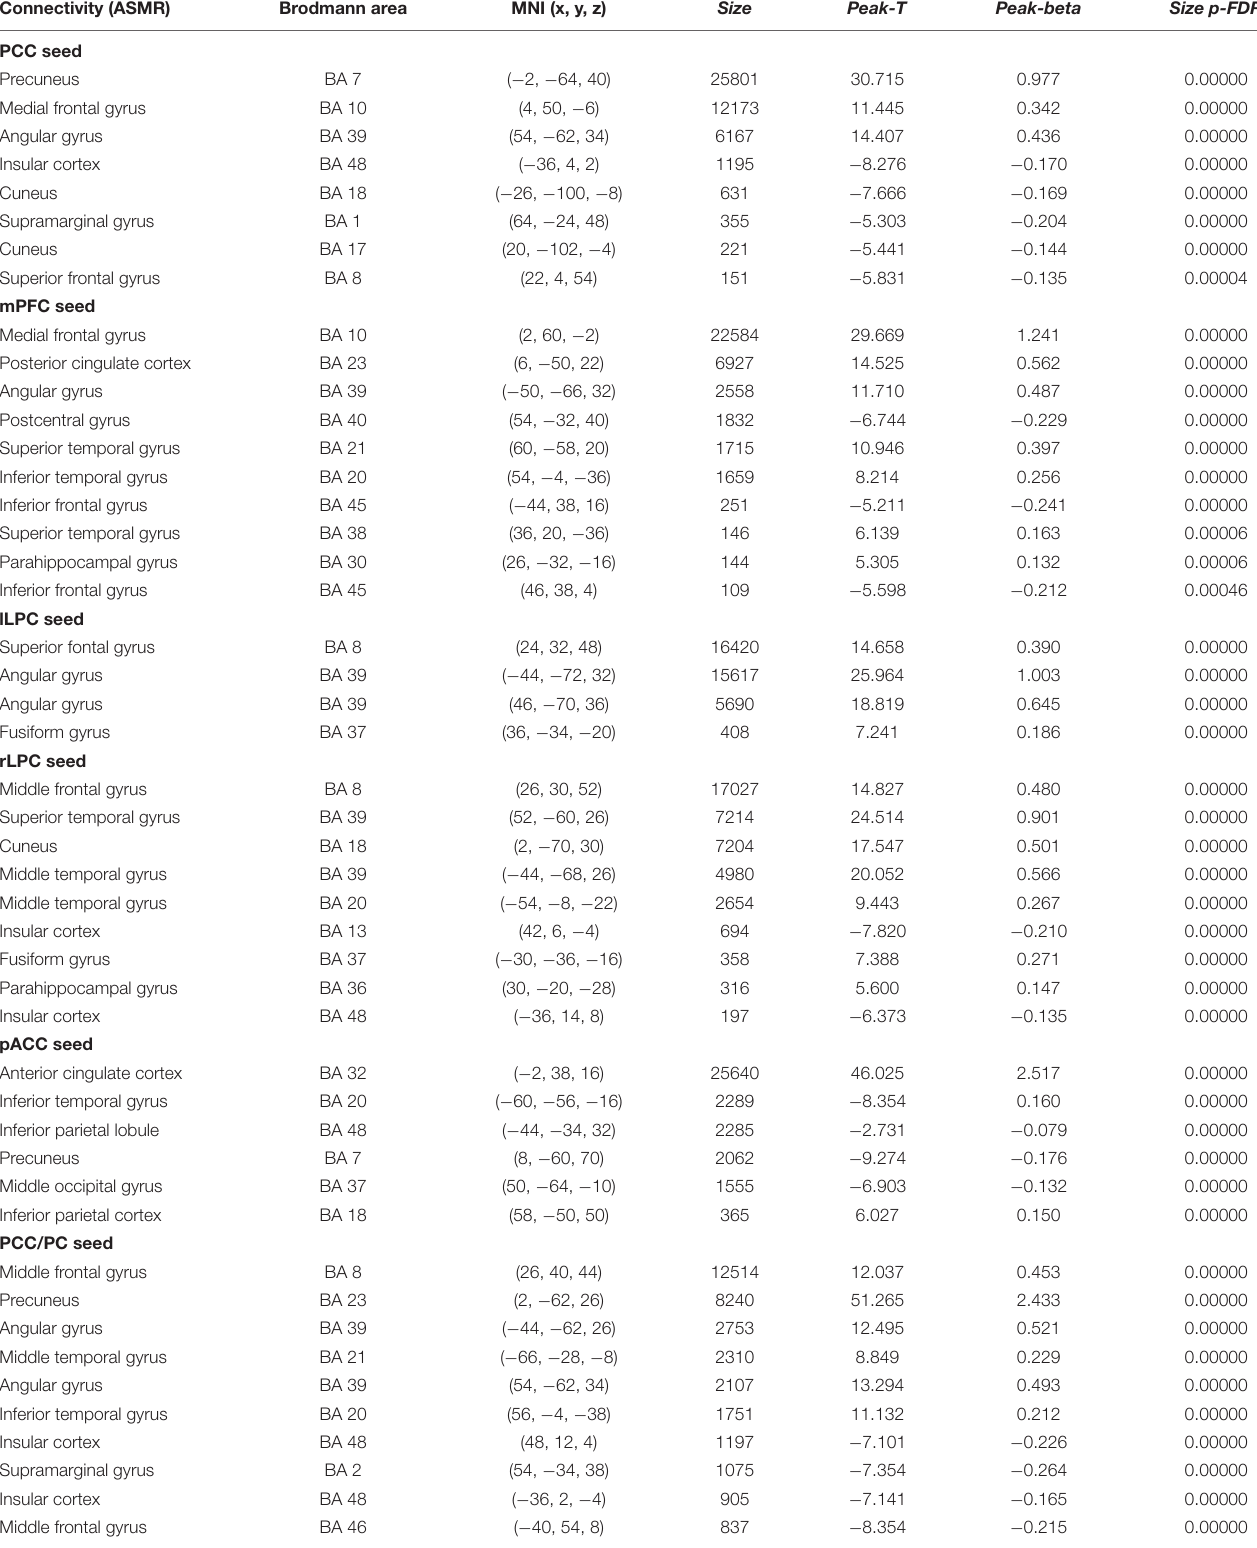
TABLE 1 | Statistical significance of the group-level functional connectivity generated during ASMR condition. Connectivity